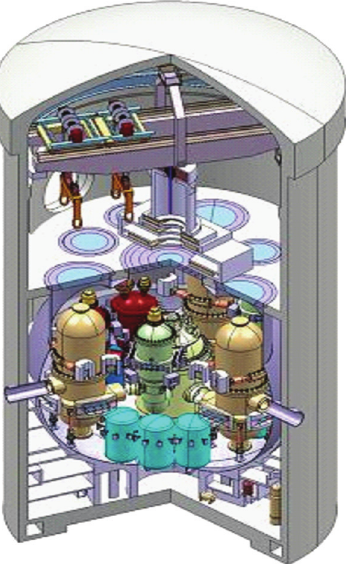
Figure 3: Layout of the 2400MWth GFR in its containment building.